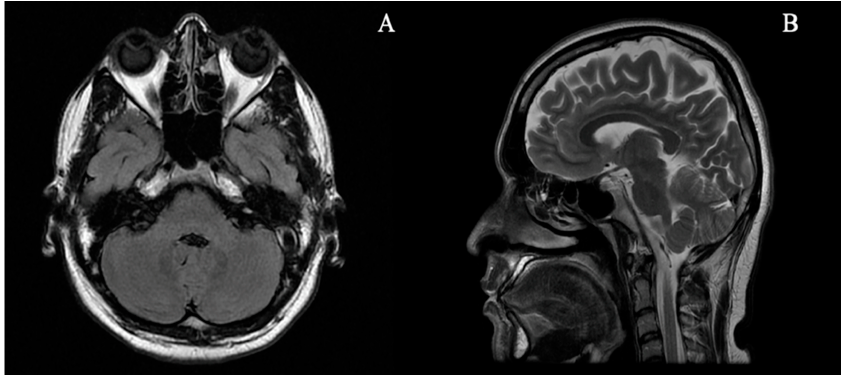
Figure 1. Magnetic Resonance Imaging of the brain showing no significant abnormalities and no cerebellar atrophy. ( A ) Axial Flair weighted image. ( B ) Sagittal T2 weighted image. A diagnosis of anti-GAD associated ataxia and ophthalmoparesis was made. The patient was treated with methylprednisolone (1 g/day) for five days with only